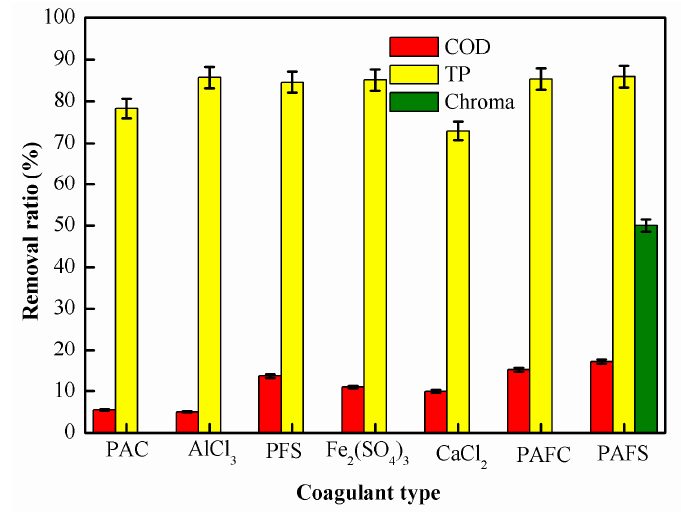
Figure 1. Effect of coagulant type on coagulation performance.